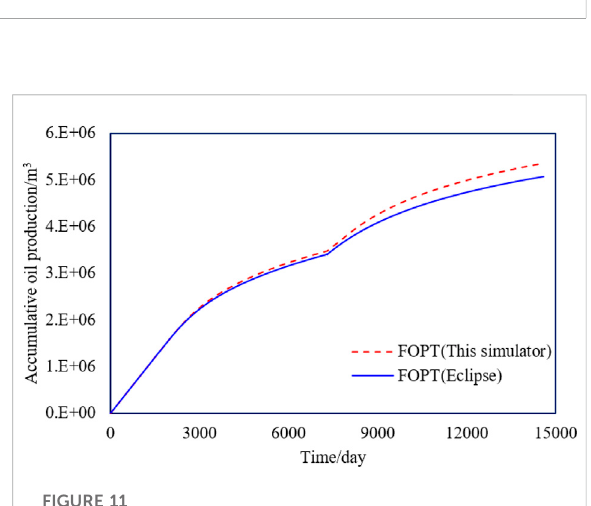
FIGURE 11 Comparison curve of cumulative oil production of different